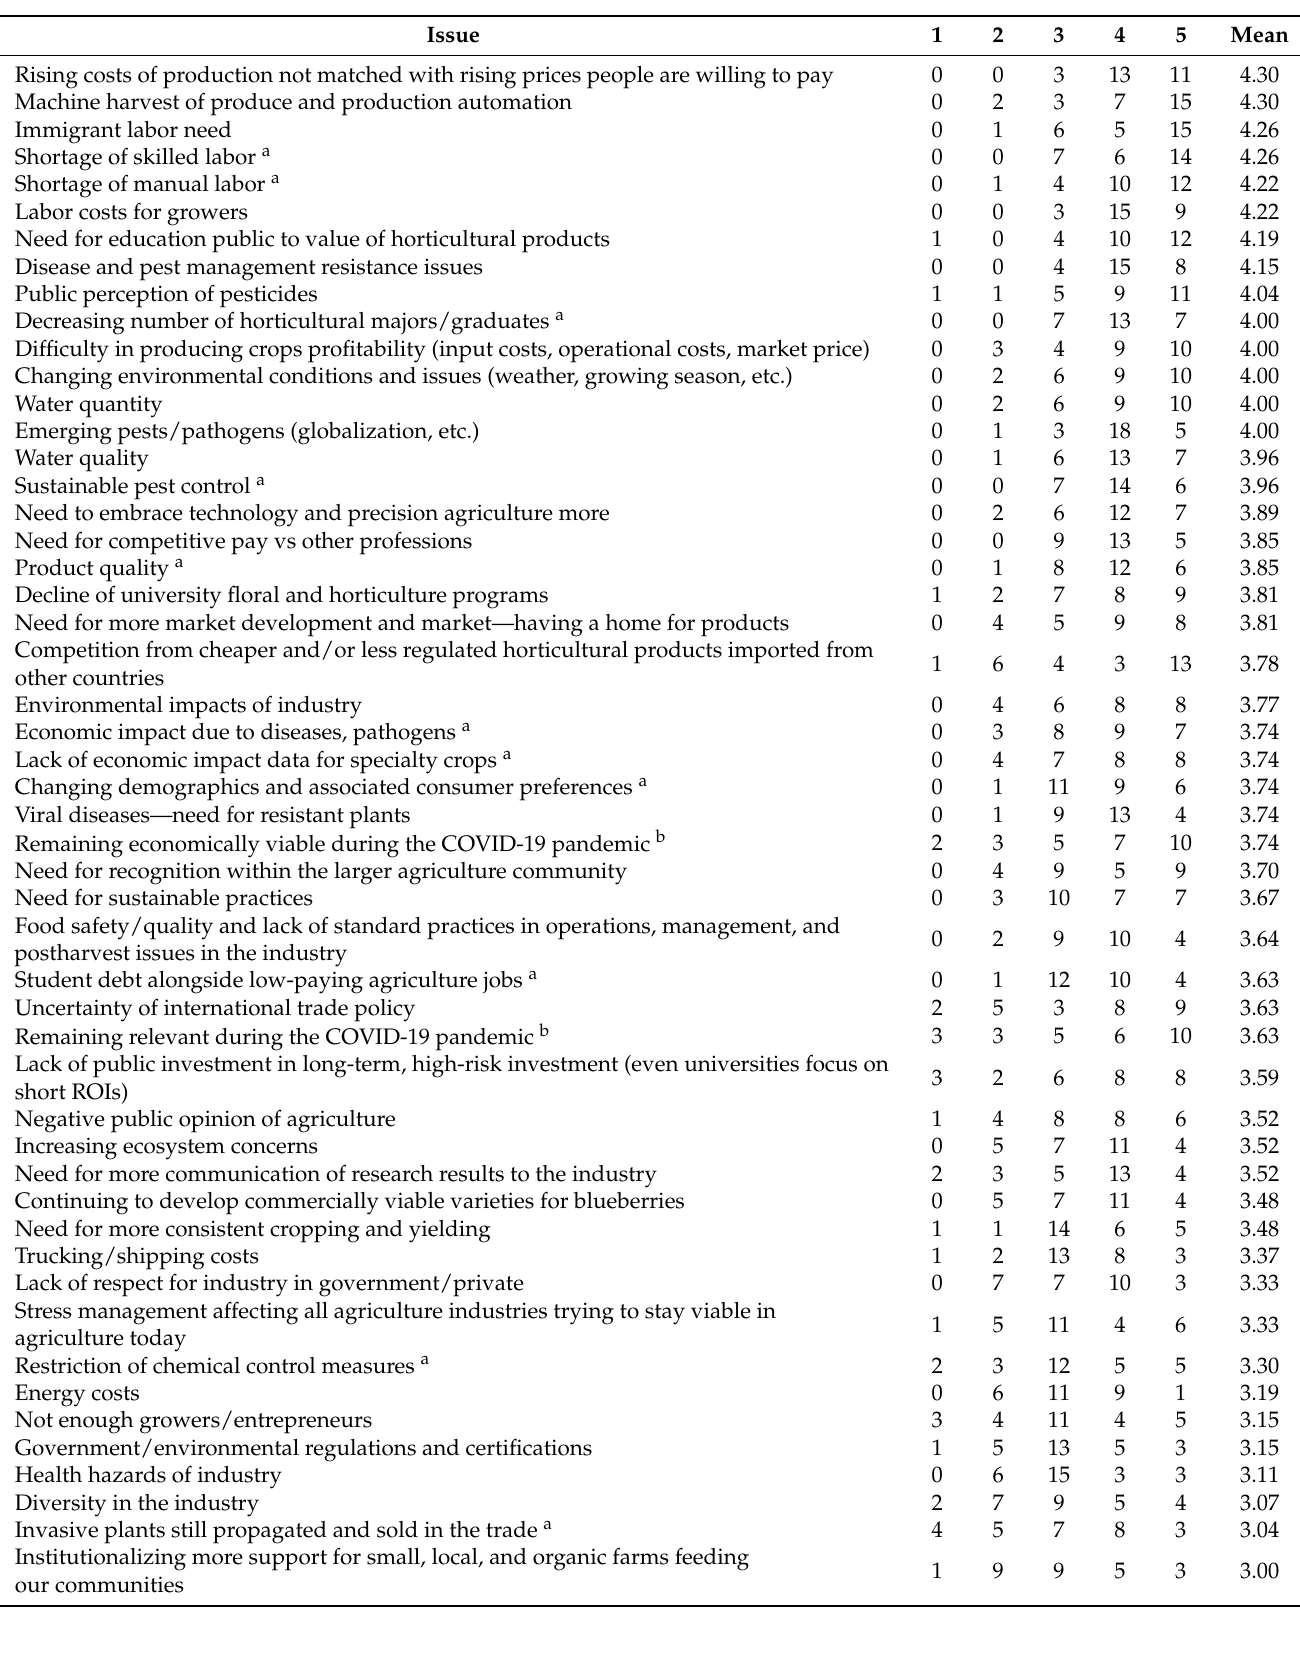
Table 2. Delphi round two results: level of importance for critical issues facing industries related to horticulture (1 = least important; 5 = most important) ( n =